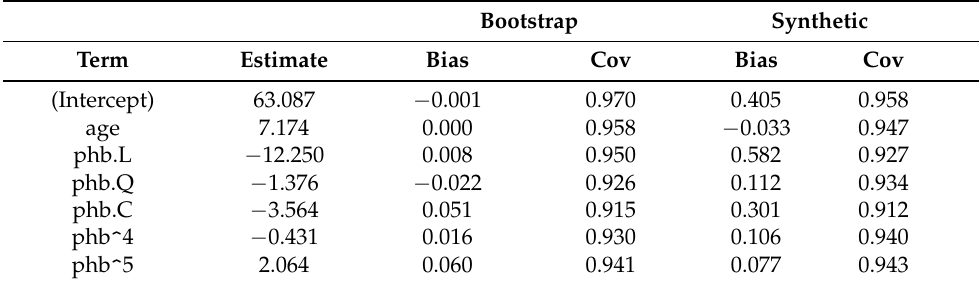
Table 4. Simulation results for a linear regression model with continuous and ordered categorical age + phb . Depicted are the true data estimates and predictors. The model evaluated is hgt ∼ the bias from the true data estimates and the coverage rate of the 95% confidence interval for the bootstrap and synthetic data